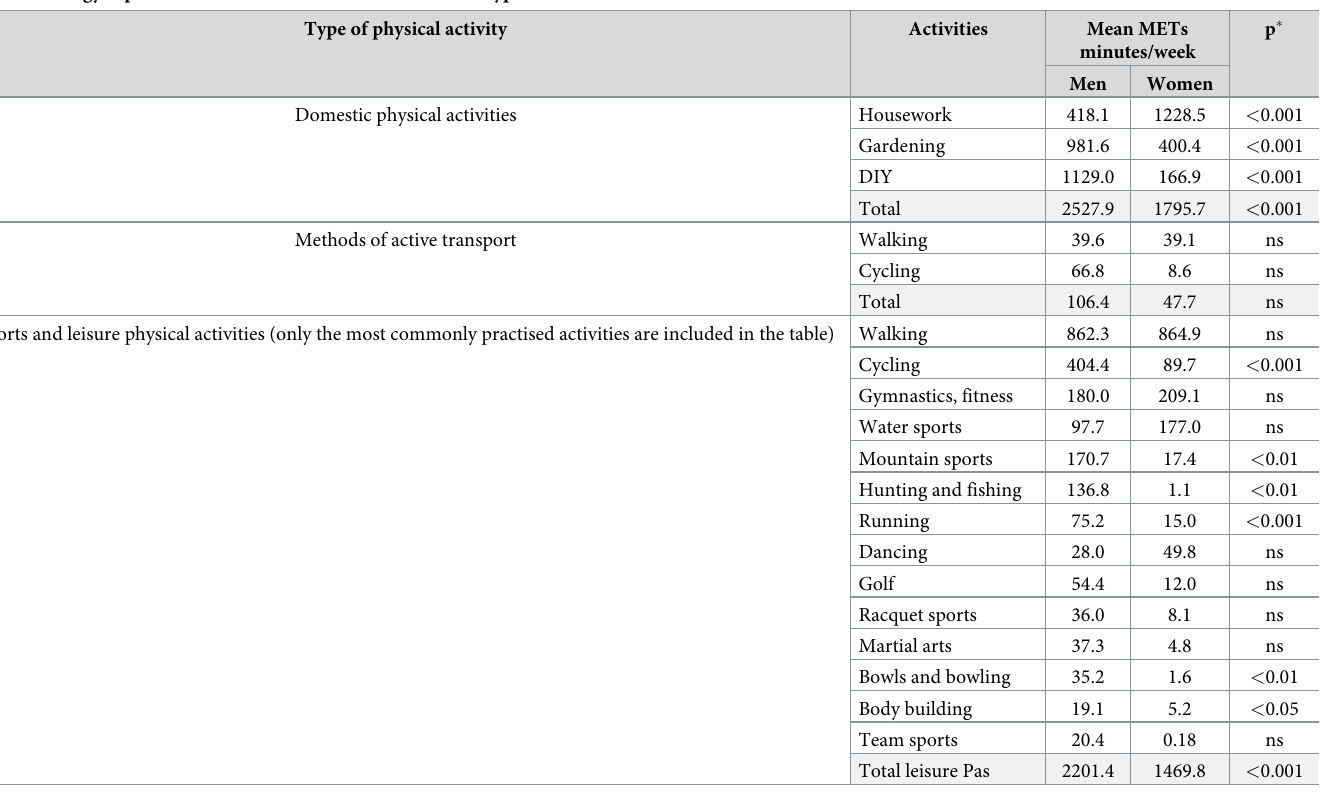
Table 5. Energy expenditure for men and women for different types of PA.